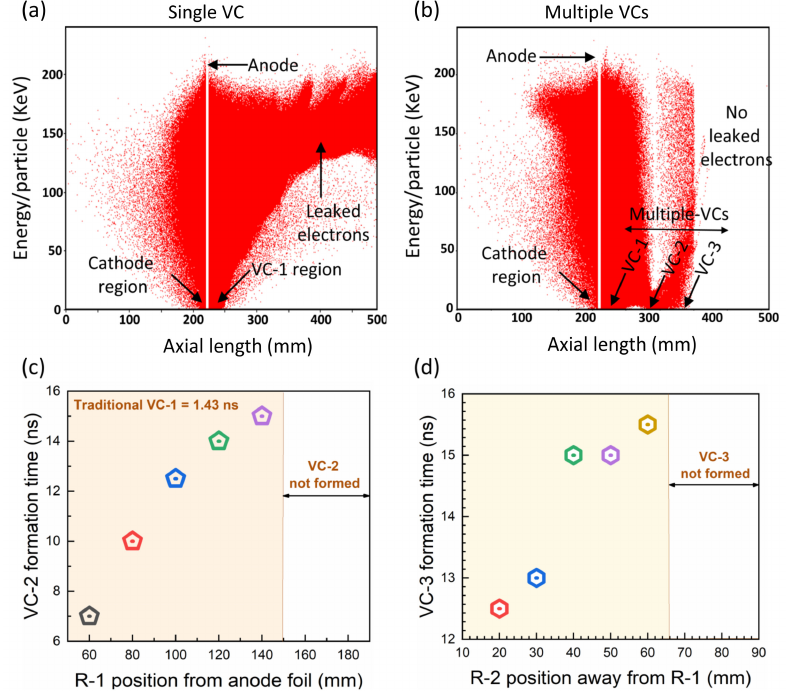
Figure 4. The simulation results, where ( a , b ) show the IREB particle KE with a single VC and multiple VCs, respectively. The position of VC is where the KE of electrons drops to zero. Multiple VCs exhibit no axial loss of electrons in the form of LE. The ( c , d ) show the formation time of the traditional (VC-1), which is 1.41 ns, and the second VC-2 by adding and changing the position of the first reflector R-1, and the formation time of VC-3 by adding and changing the position of the second reflector R-2, respectively. The results show that the position of multiple VCs highly depends on the position of